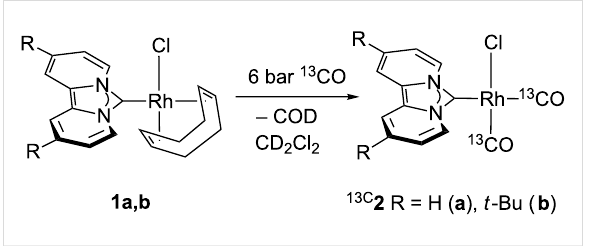
lating the metal–ligand electronic parameter (MLEP)